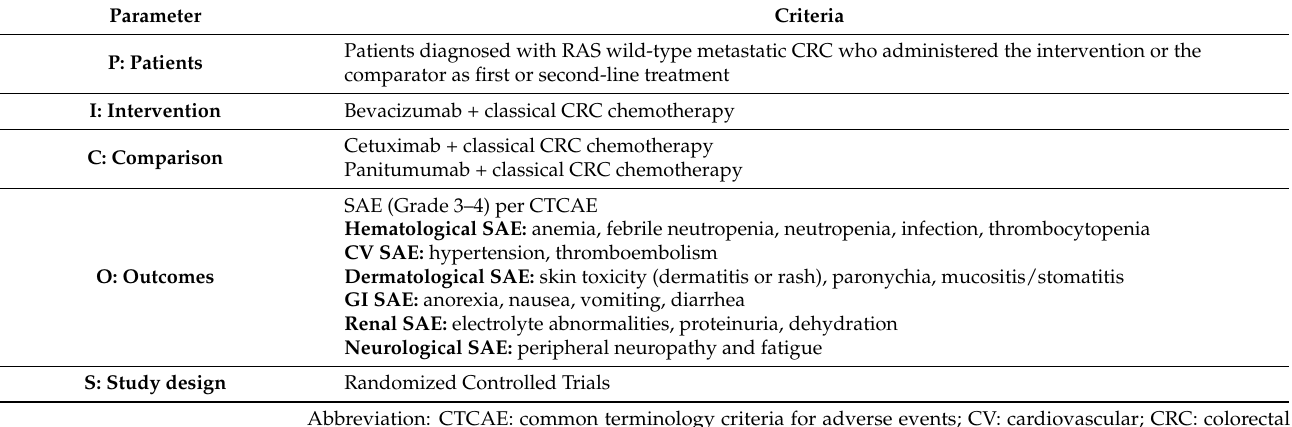
Table 1. PICOS criteria for study selection.